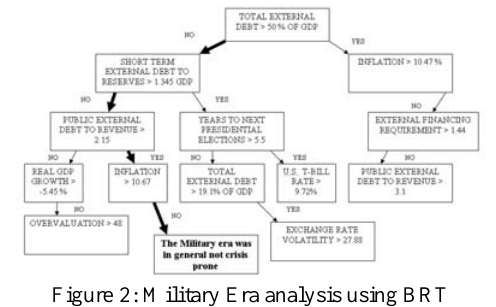
Figure 2: Military Era analysis using